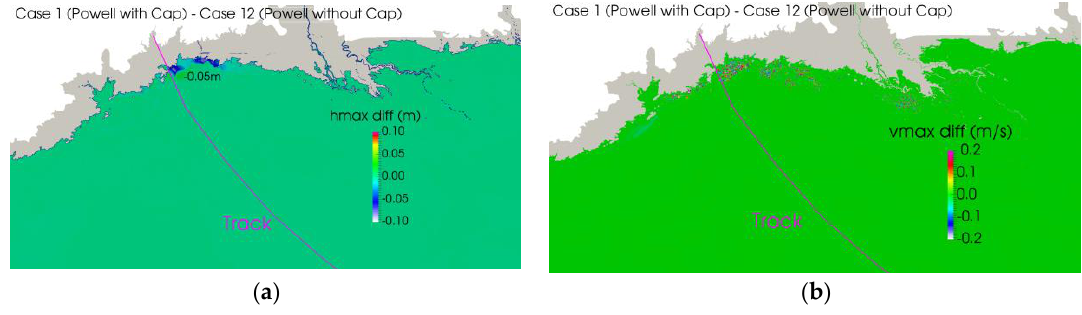
Figure 13. Contour plots of maximum water elevation and velocity for hindcast of Hurricane Rita storm surges. ( a ) maximum elevation difference: Case 1–Case12; ( b ) maximum velocity difference: Case 1–Case12.